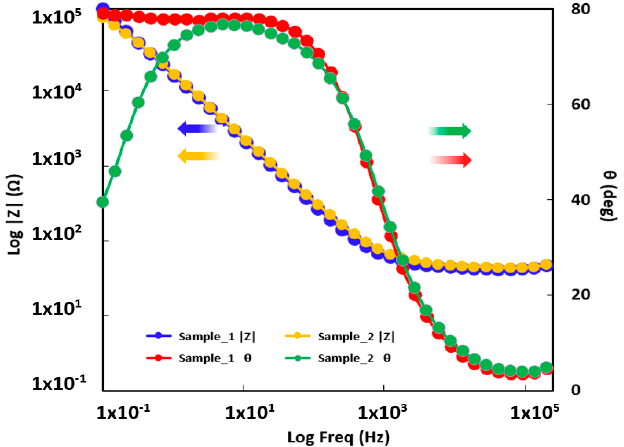
Figure 7. Bode diagrams for Sample 1 and Sample 2.